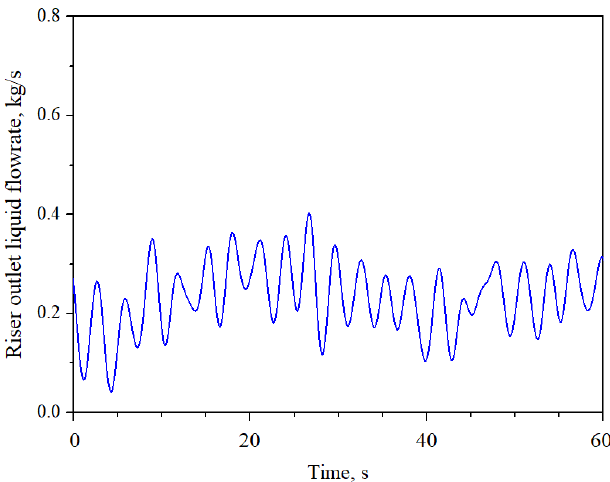
Figure 10. Experimental profile of liquid production during choking-induced bubbly flow ( U GS = 0.08 m/s and U LS = 0.09 m/s).